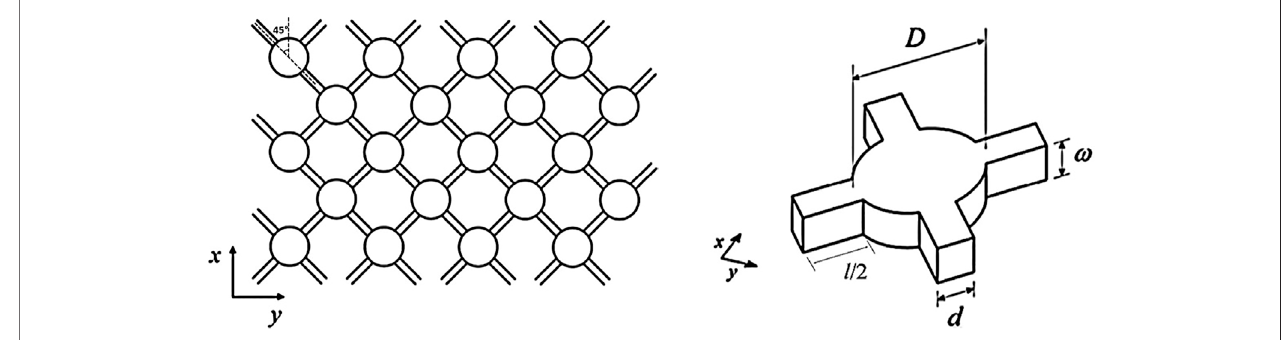
FIGURE 2 | Schematic representation of: NETmix network (A) and NETmix unit cell geometries (adapted from Fonte et al., 2013) (B)